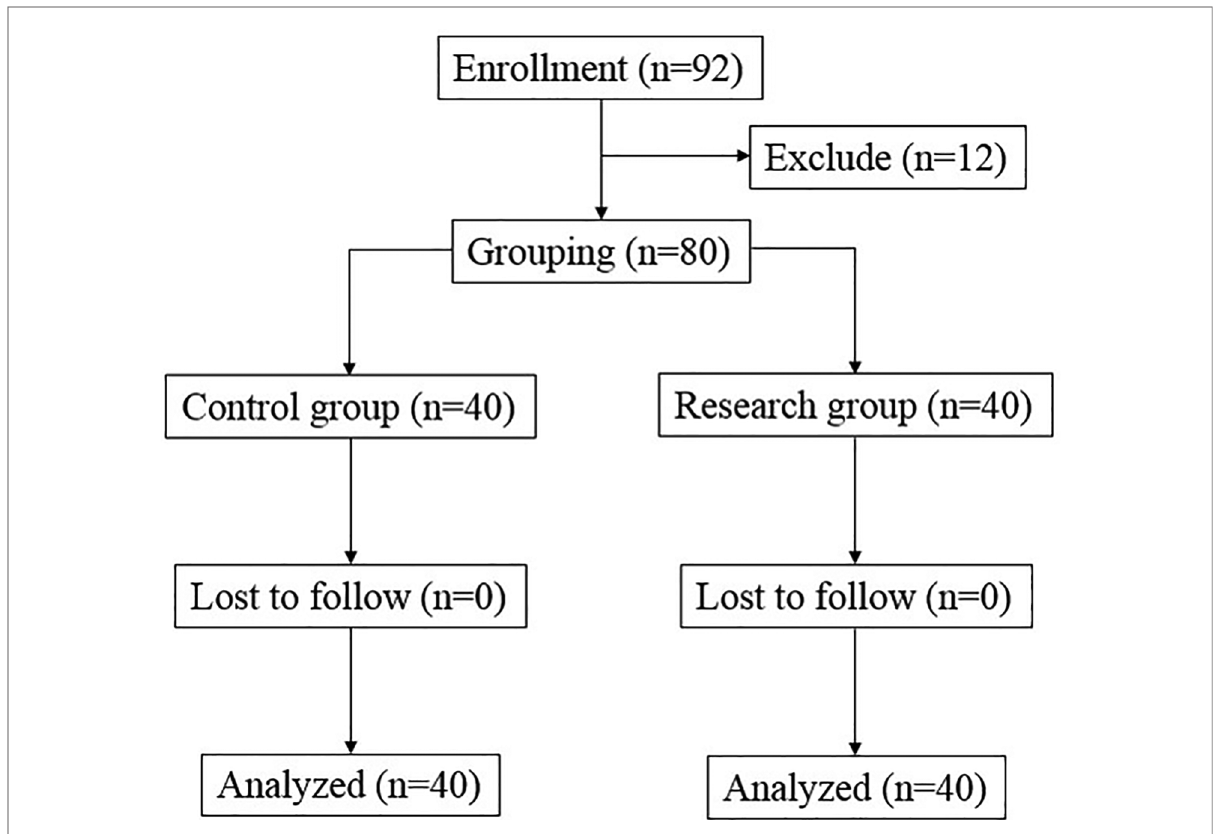
FIGURE 1 Flow diagram of the study.